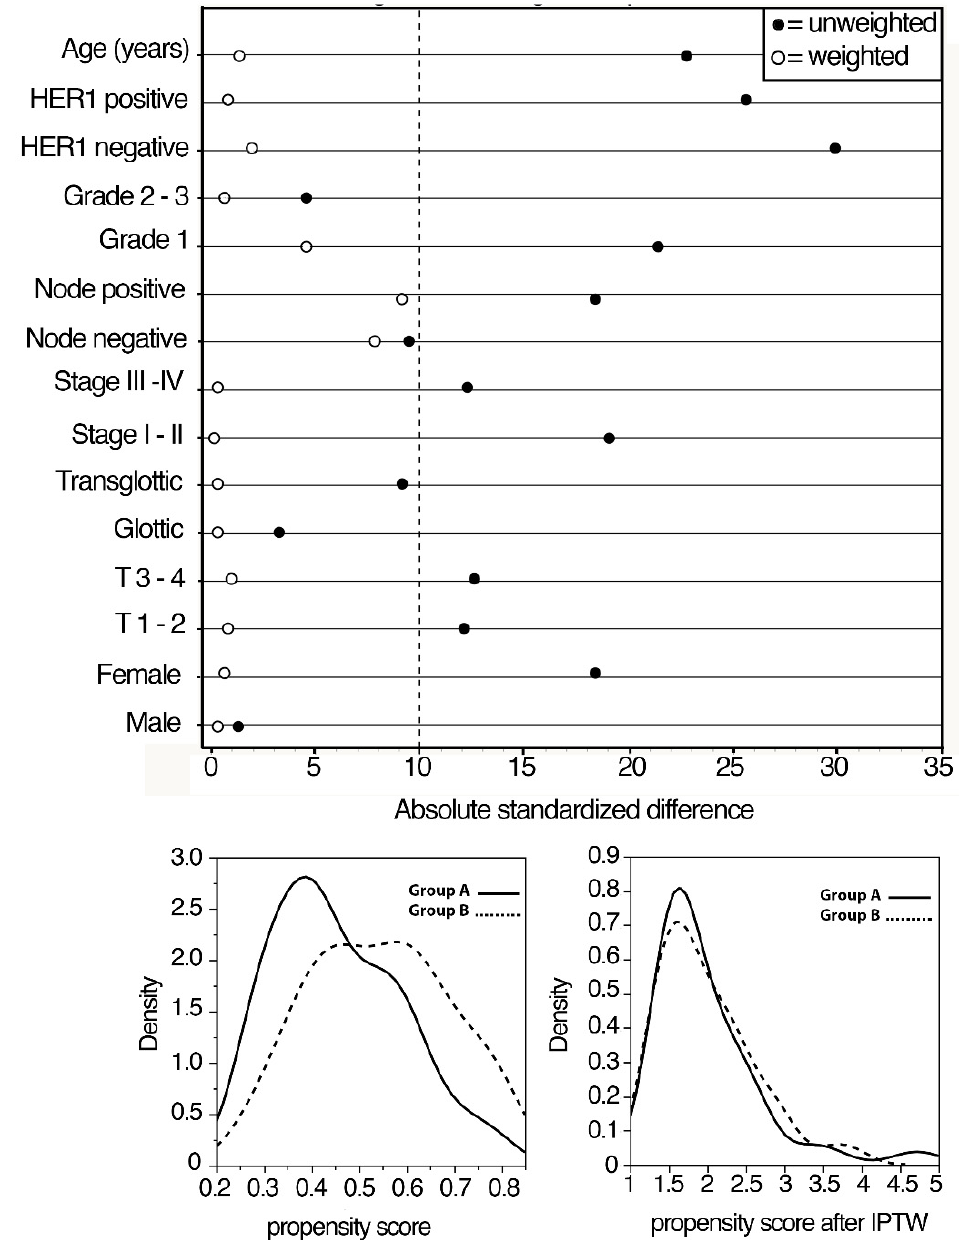
Figure 1. Absolute standardized differences in unweighted and inverse propensity score weighted samples.